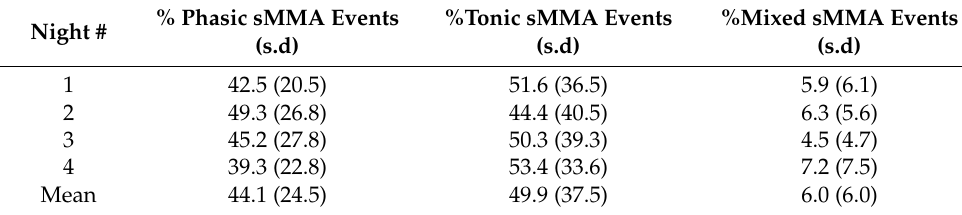
Table 2. Percentage distribution of phasic, tonic, and mixed sMMA events over each recording night. Night #